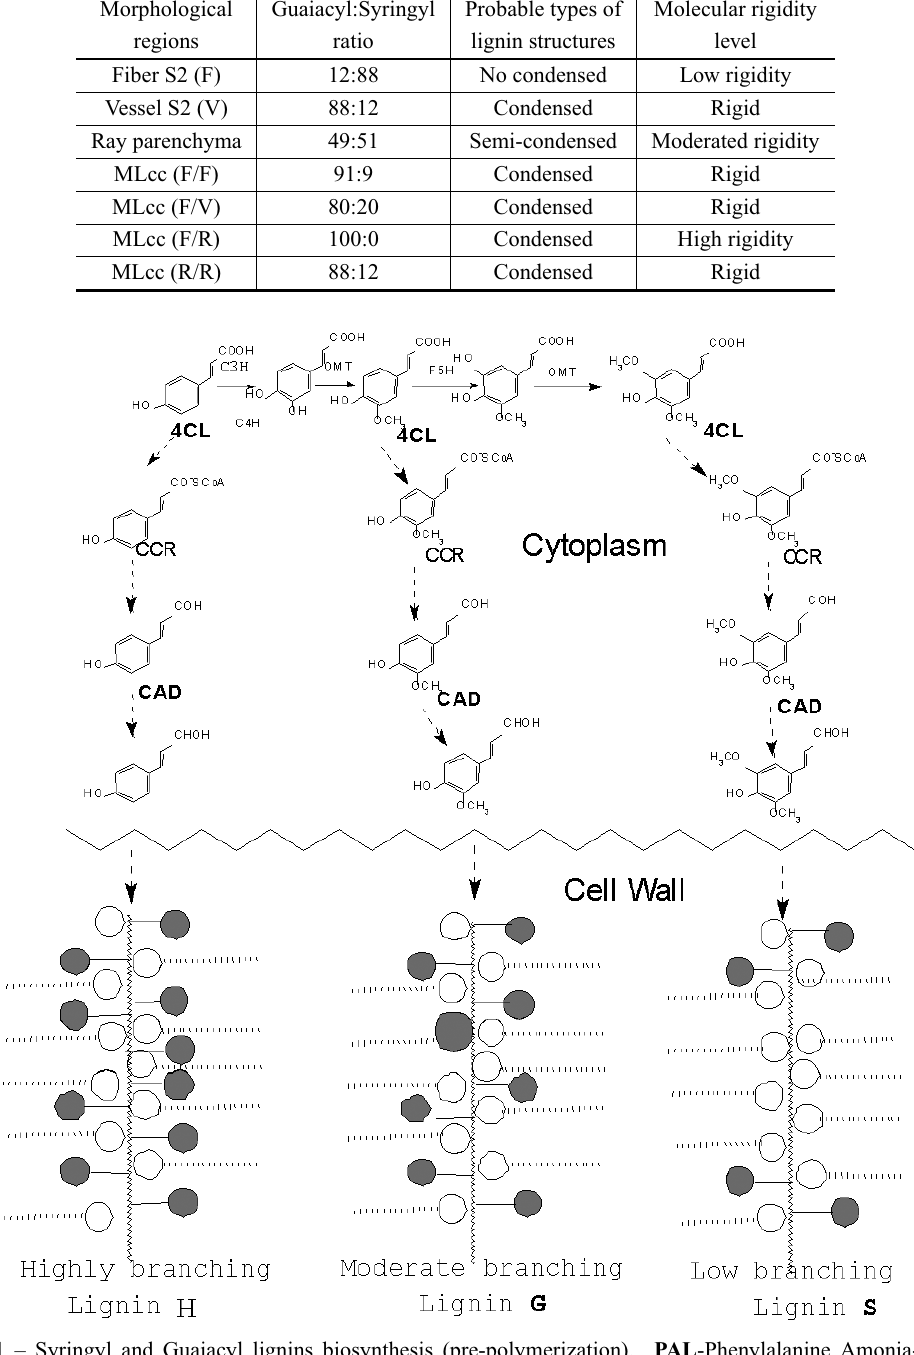
Guaiacyl/Syringyl ratio in the lignins of birch cells (Higuchi 1984, Abreu et al. 1999) and their structural and rigidity level, respectively.